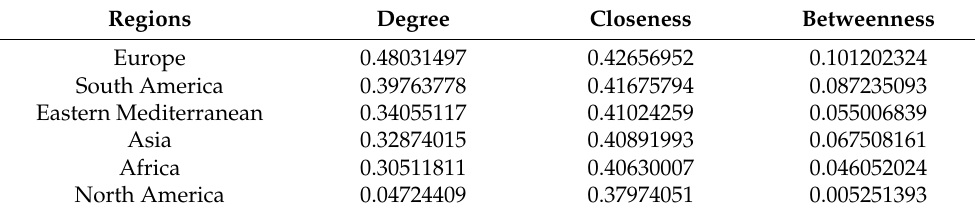
Table 1. Centralities of COVID-19 government websites across